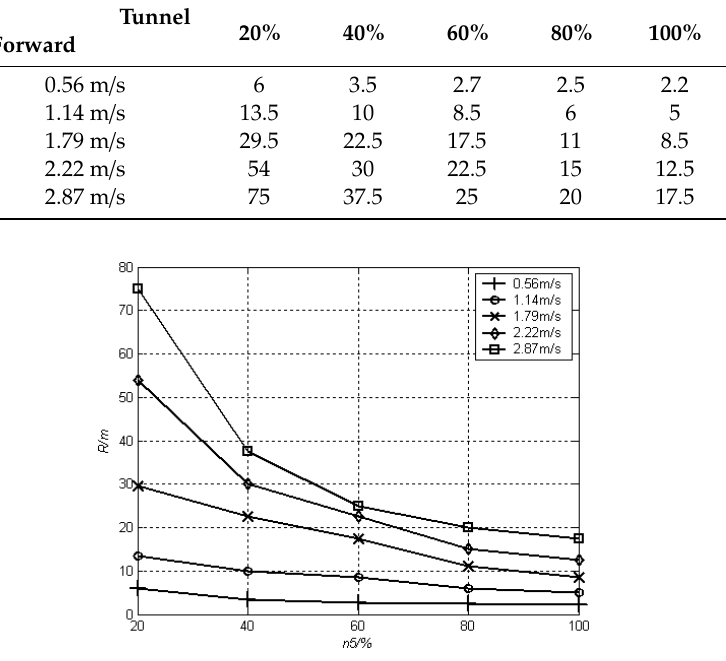
Figure 30. Heading keeping with −5°. 5.2. Path Following Experiment In order to verify the performance of different algorithm, lookahead-based LOS guidance algorithm was adopted first (